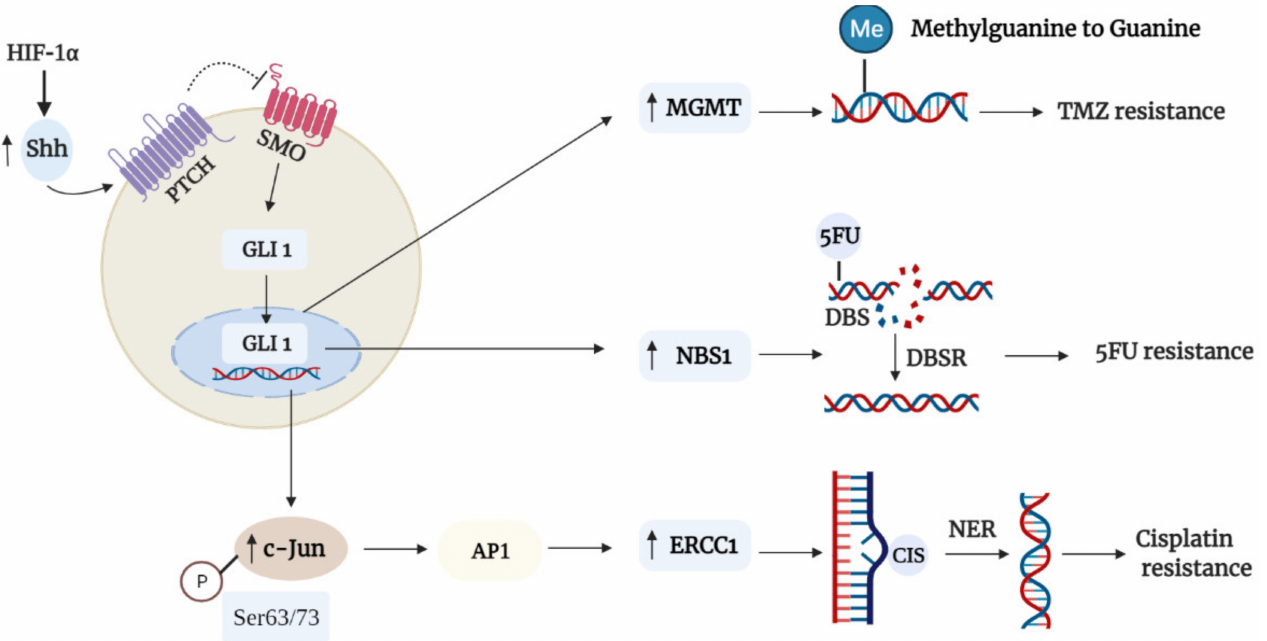
Figure 1. A schematic representation of the Hedgehog (Hh) signaling in the regulation of different DNA repair mechanisms to promote chemoresistance. Under the hypoxic condition, HIF-1 α stimulation triggers the autocrine secretion of Shh, which activates canonical Hedgehog-glioma-associated oncogene homolog 1 (Hh-GLI1) signaling in tumor cells to induce high levels of MGMT. Consequently, MGMT repairs O-6-methylguanine lesions induced by TMZ, which results in TMZ resistance. Activation of Hh-GLI1 signaling also upregulates NBS1 of the MRN complex as well as promotes c-Jun phosphorylation (Ser63/73) and AP1-mediated upregulation of ERCC1 to repair DNA breaks induced by 5-FU and cisplatin,